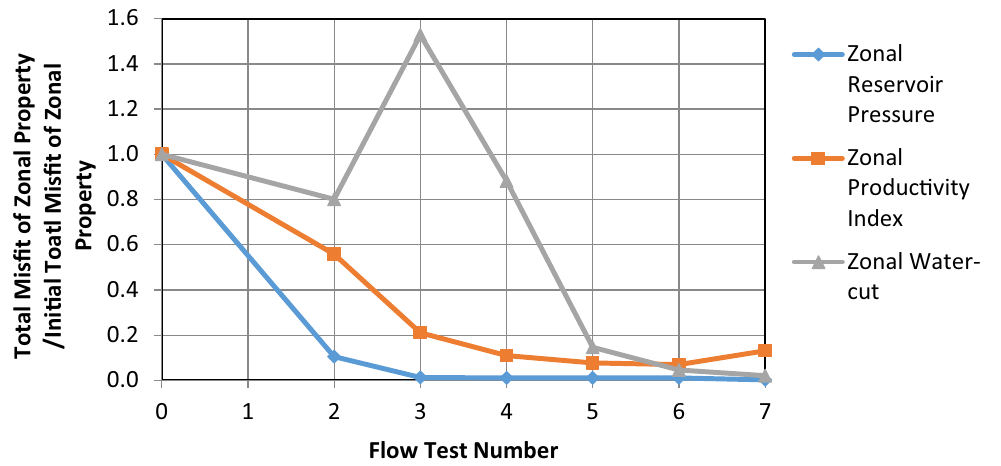
Fig. 11 Estimation of different zonal properties versus flow tests